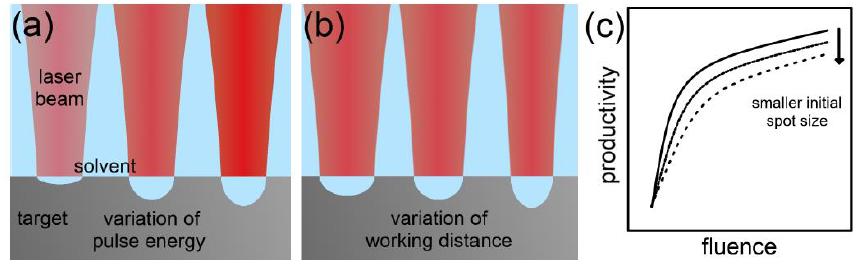
Figure 7. Effect of laser fluence on the ablation rate due to ( a ) pulse energy and ( b ) working distance. ( c ) Productivity of NPs vs. fluence by different initial spot sizes [45].